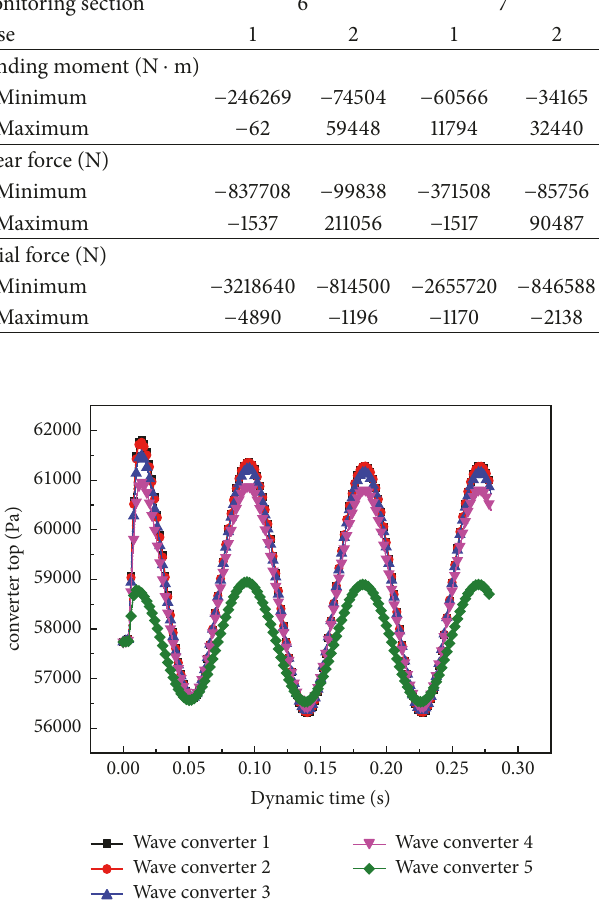
Figure 16: Stress-time curves of the wave converter top. Figure 17: Stress-time curves of the wave converter bottom.